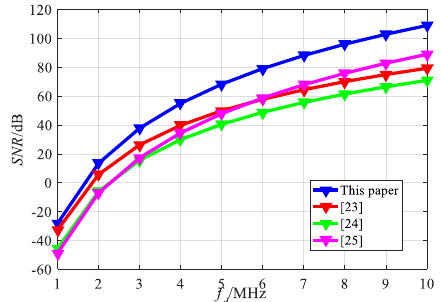
Figure 18. Comparison between different works.